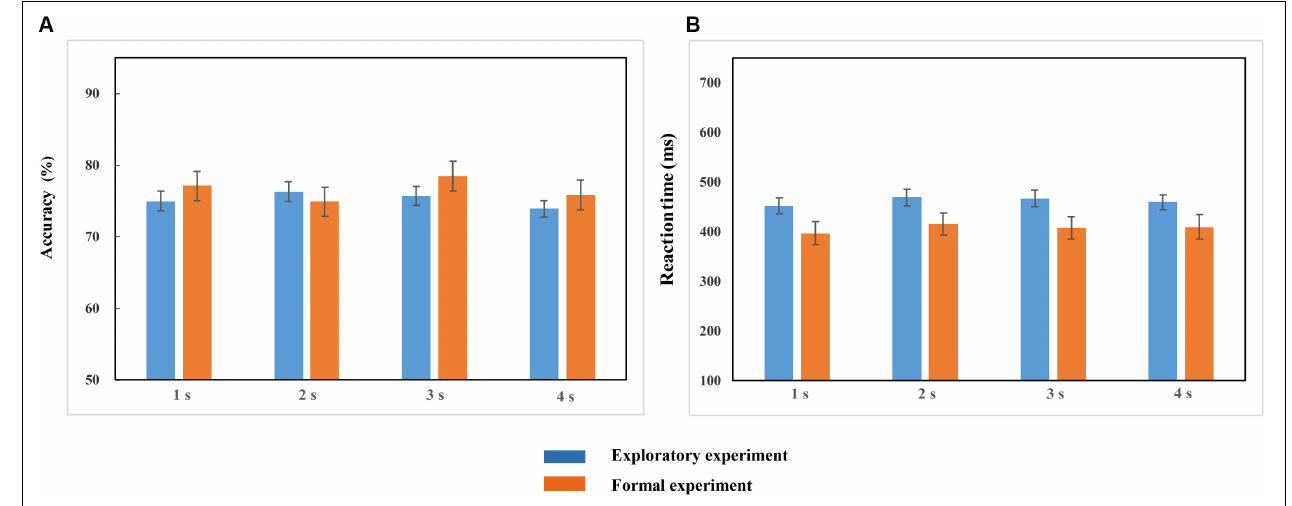
FIGURE 3 | Accuracy (A) and Reaction time (B) in the 1, 2, 3, and 4-s duration conditions in the exploratory experiment and formal experiment. Blue and red bars represent the accuracy (A) and reaction time (B) of four duration conditions in the exploratory experiment and the formal experiment, respectively. Error bars represent the SEM across